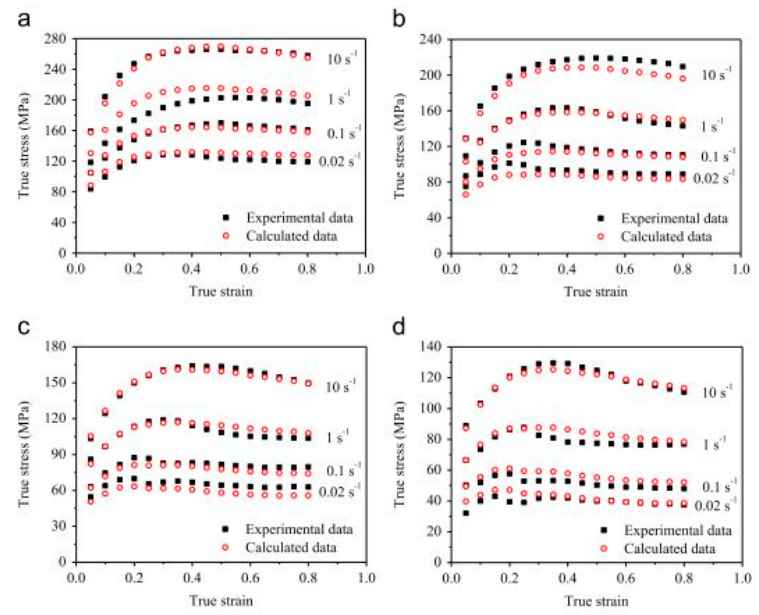
Figure 39. Comparison of the experimental and calculated stress–strain curves at different conditions [95]